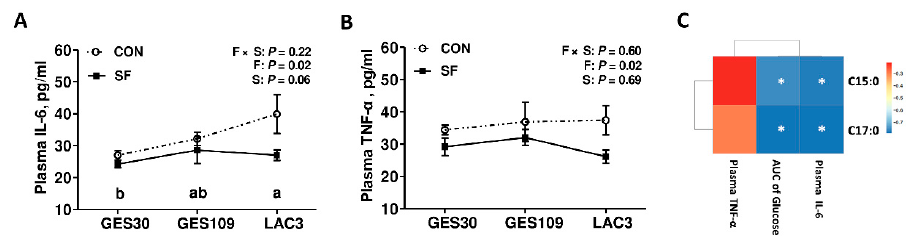
Figure 6. E ff ects of soluble fiber during gestation on systemic inflammation of sows. Comparison of plasma IL-6 ( A ) and TNF- α ( B ) between CON- and SF-fed sows. ( C ) Heatmap of the Spearman R correlations between odd-chain fatty acids and insulin sensitivity and systemic inflammation parameters of sows. Data are expressed as mean ± SEM ( n = 8). * p < 0.05. a-b, significant e ff ect of breeding stage ( p < 0.05; values with di ff erent lowercase letters are significantly di ff erent). GES109, day 109 of gestation; LAC3, day 3 of lactation. CON, control diet; SF, 2.0% soluble fiber combination diet. IL-6, interleukin 6; TNF- α , tumor necrosis factor α